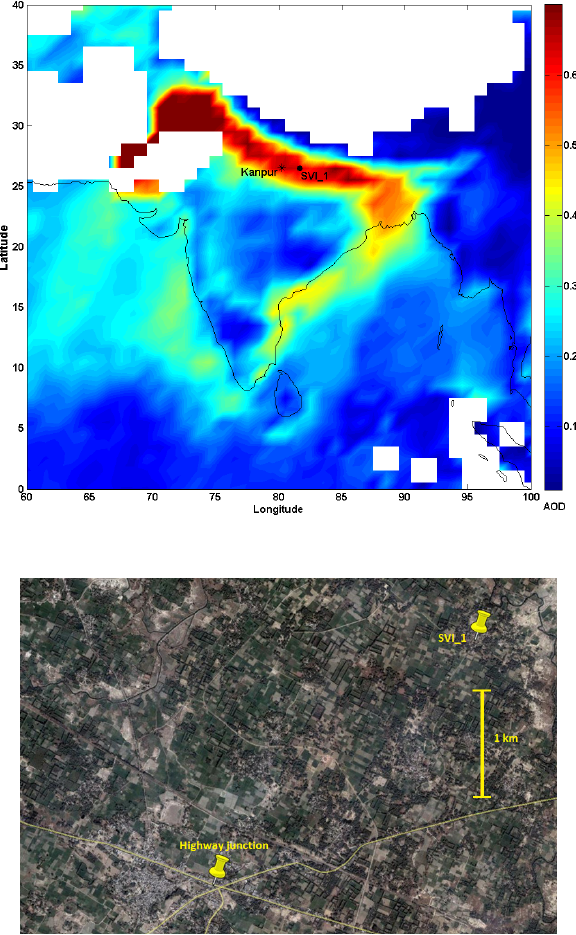
Fig. 1. (above) MODIS TERRA monthly mean aerosol optical Figure 15 depth (AOD) over India for November 2009. Also shown is our sampling site Surya village (SVI 1) located in the IGP region along with adjacent urban center Kanpur (26.30 ◦ N, 80.31 ◦ E). (below) Local map showing locations of SVI 1 and highway